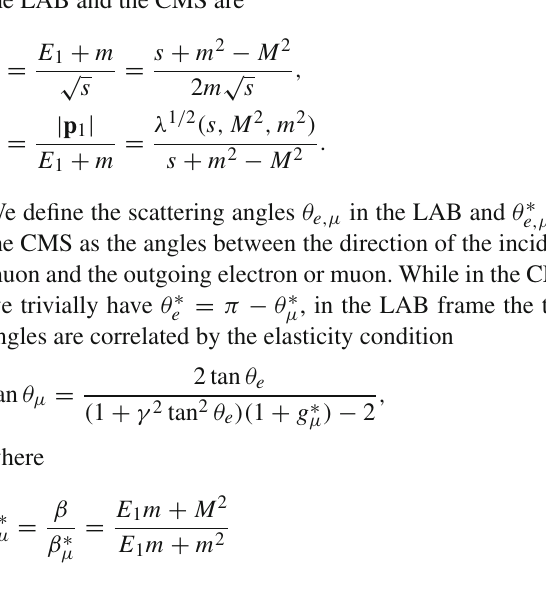
Fig. 2 The relative importance of the HVP at NLO in μ - e scattering as a function of θ